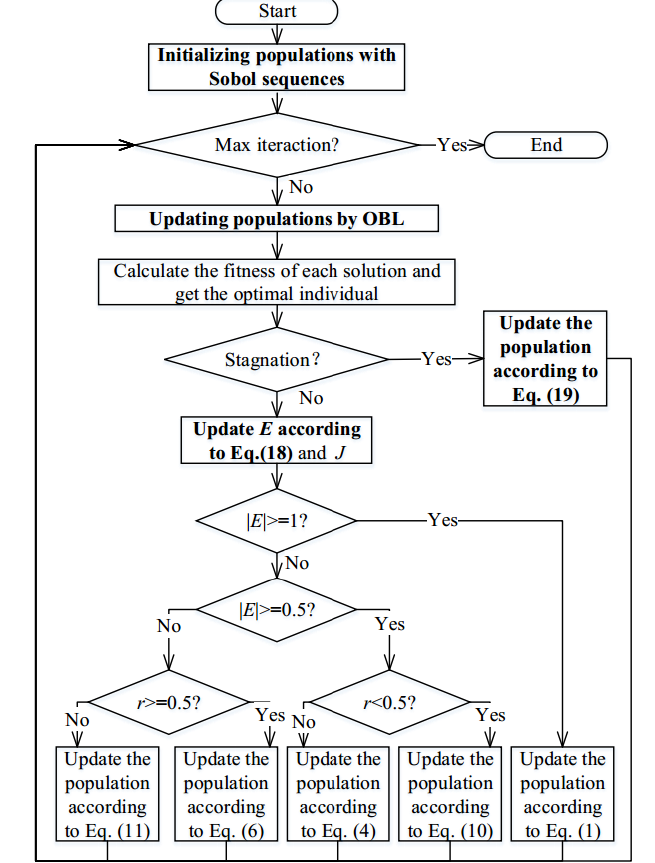
Figure 5. The flow chart of